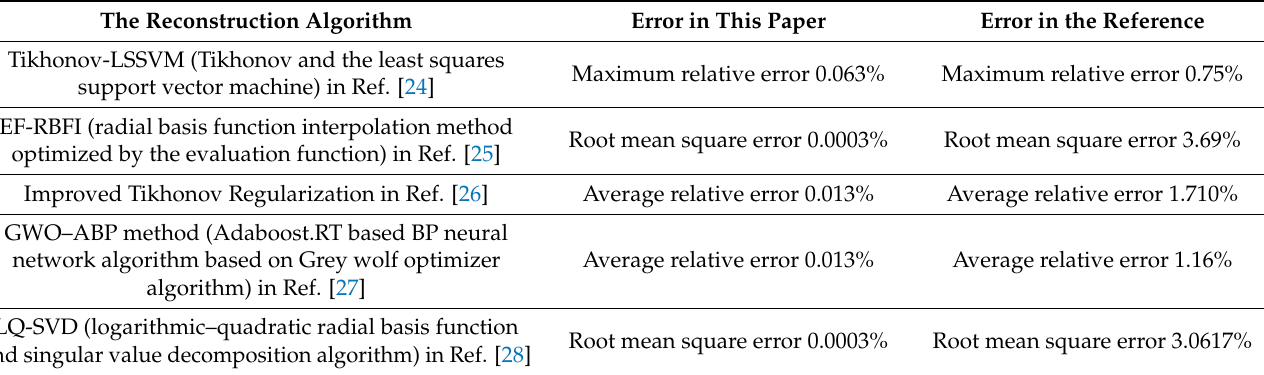
Table 6. Comparison of single-peak temperature field reconstruction error with other reconstruction algorithms in the other